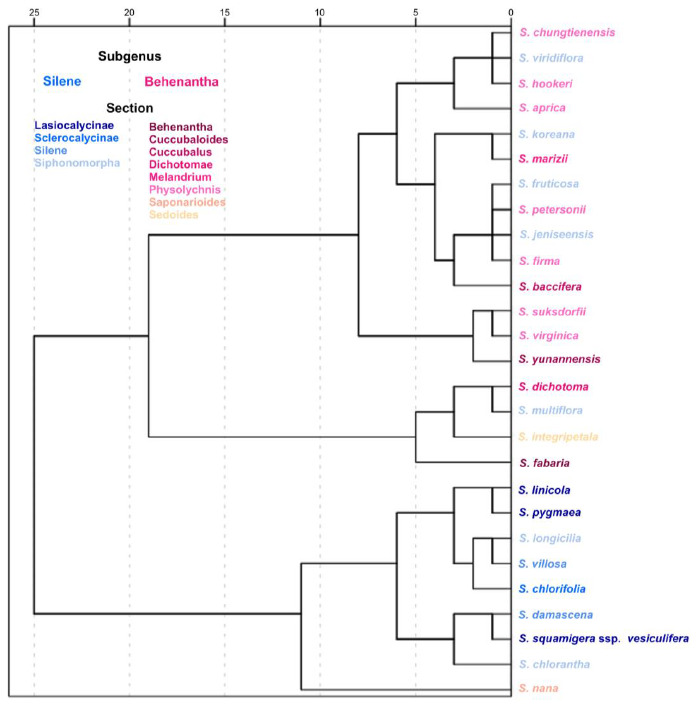
Figure 21. Dendrogram based on hierarchical clustering with the values of J index obtained from the analysis with lateral models LM2/4 and LM5. Species of subg. Behenantha are concentrated in the upper part of the diagram, while species of subg. Silene are grouped in the lower branches, excluding those species of sec. Siphonomorpha , that are scattered through the dendrogram. Results are shown for the 27 species of Table 1.